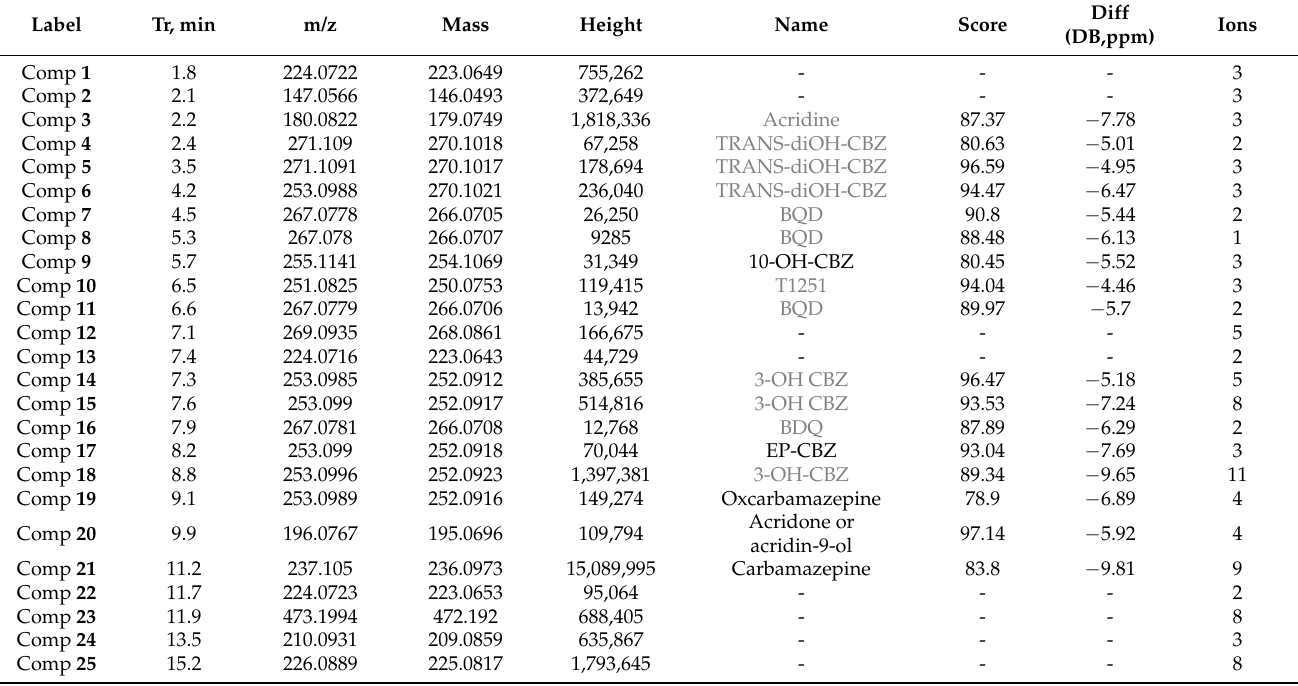
Table A3. Results of screening of major compounds. Sample pH = 4.0. Experimental conditions: [CBZ] = 50.0 mg/L; [Fe] = 10.0 mg/L; [H 2 O 2 ] = 15.0 mM; T = 25 ◦ C; [UV] = 150W. The compounds indicated in grey are the possible species identified by the